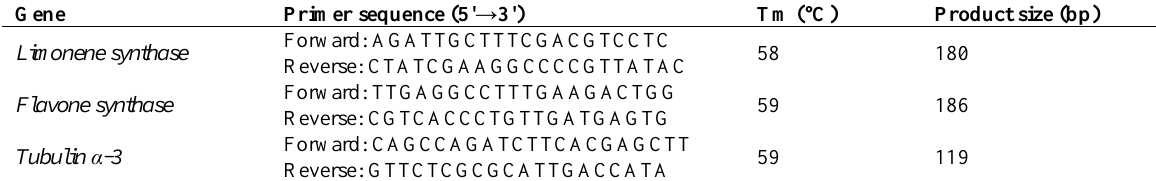
Table 2. Designed primers for real-time PCR.